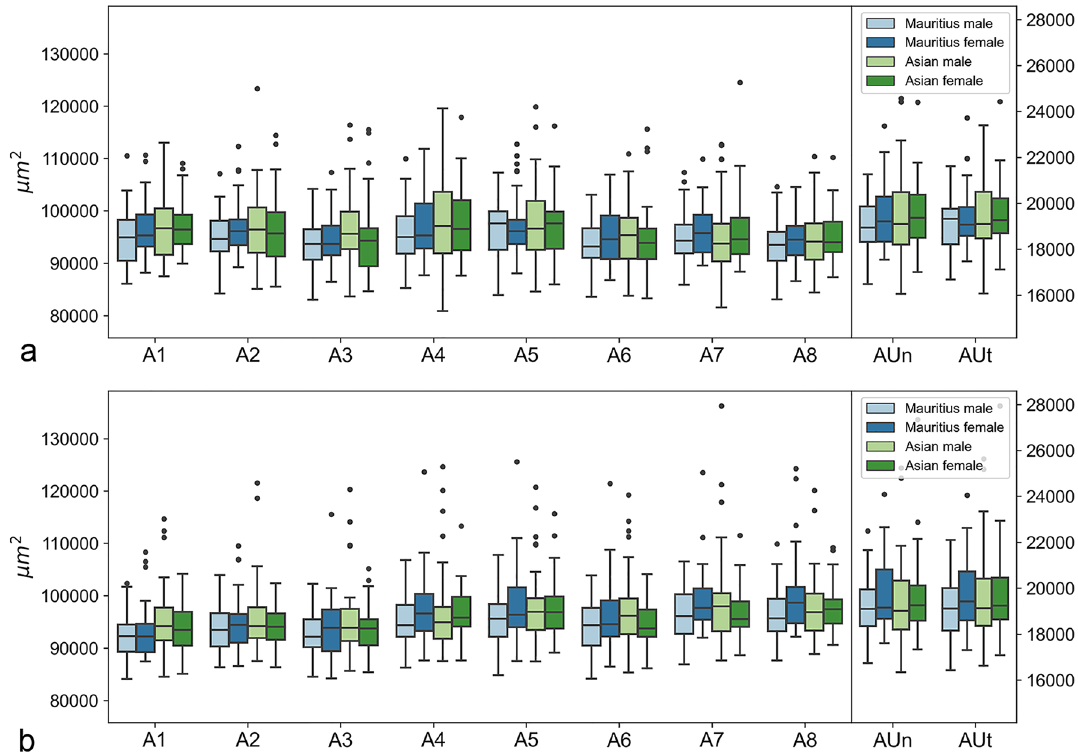
Figure 4. Boxplots of sex-specific and origin-specific variations in choroidal areas for right ( a ) and left ( b ) eyes. Numerical data of Mauritius male, Mauritius female, Asian male, and Asian female are plotted for each area